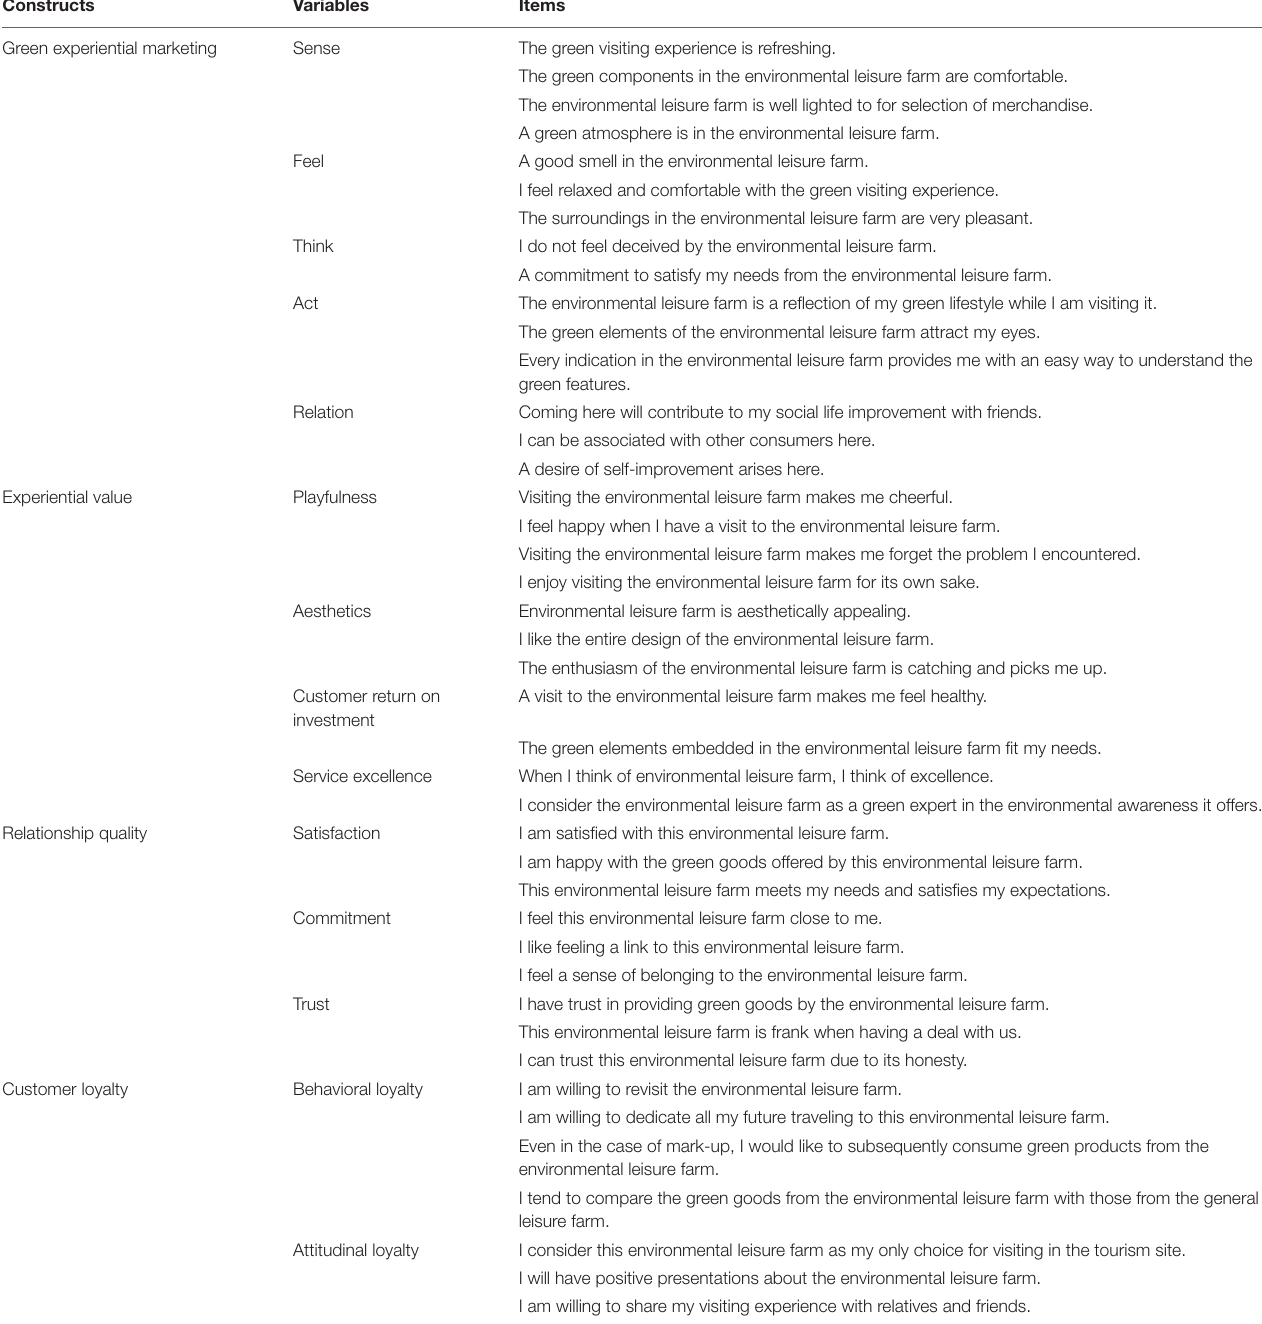
TABLE 2 | Scale of measurement variables. Constructs Variables Green experiential